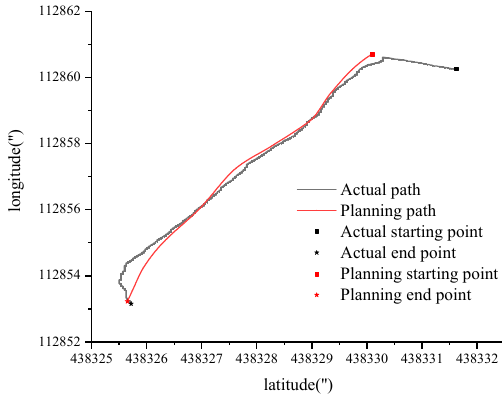
Figure 26. An AUV of Harbin Engineering University.